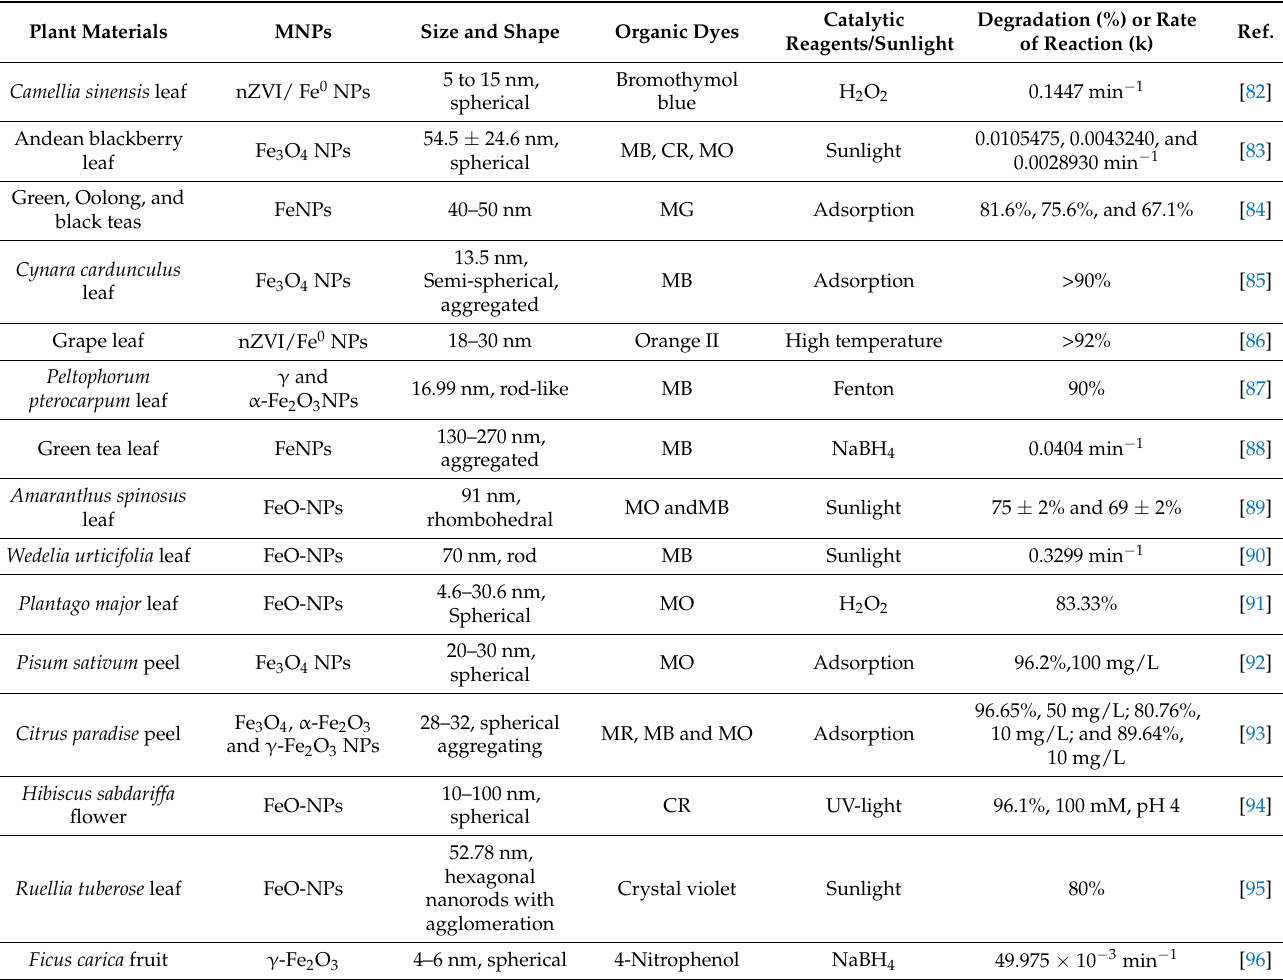
Table 3. Synthesis of iron/iron oxide nanoparticles using different plant extract and its degradation efficiency. Plant